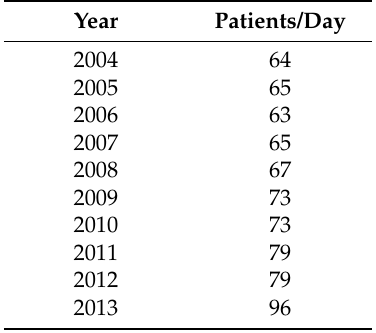
Figure 1. Numbers of Patients. Absolute numbers of patients per year presenting to the Emergency Centre (UNZ), by year ( N = 264,272 patients). Table 1. Mean daily number of patients presenting to the Emergency Centre by year ( N = 264,272 patients, ±SD = 9.68).